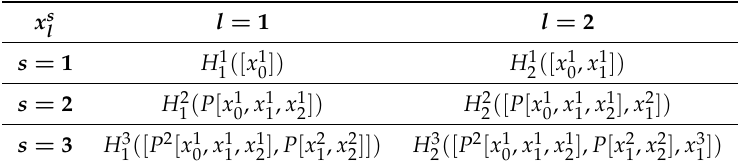
Figure 4. Fully dense connectivity pattern. For simplicity, each scale has two Conv layers. In addition, multiscale feature maps extracted from an HSI patch are illustrated. Table 1. The output x s of layer l at the s th scale. Herein, [ · ] represents the concatenation operator. l P and P 2 refer to the 2 × 2 and 4 × 4 pooling layers,